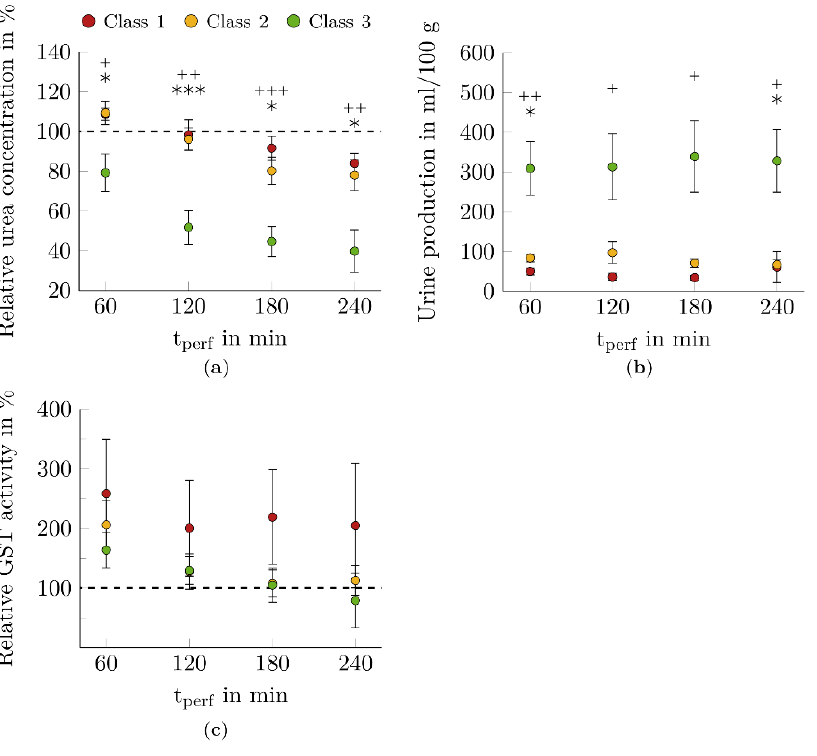
Figure 5. Course of markers for renal filtration and tubular impairment during NMP. The perfused kidneys showed a dependence between the predicted functional class and the function markers ( a ) relative urea concentration and ( b ) urine production. The relative glutathione S-transferase (GST) activity varies depending on the renal function ( c ). However, no significant differentiation of the kidneys could be observed. The dashed lines correspond to ( a ) relative urea concentration and ( b ) relative GST activity of 100% at t 0 . The data points represent the twelve times of measurement during the NMP. Shown mean ± SEM. n = 4 for nonfunctional kidneys (class 1), n = 10 for limited functional kidneys (class 2), n = 12 for functional kidneys (class 3), *, p < 0.05, ***, p < 0.001, class 2 vs. class 3; +, p < 0.05, ++, p < 0.01, +++, p < 0.001, class 1 vs. class 3.